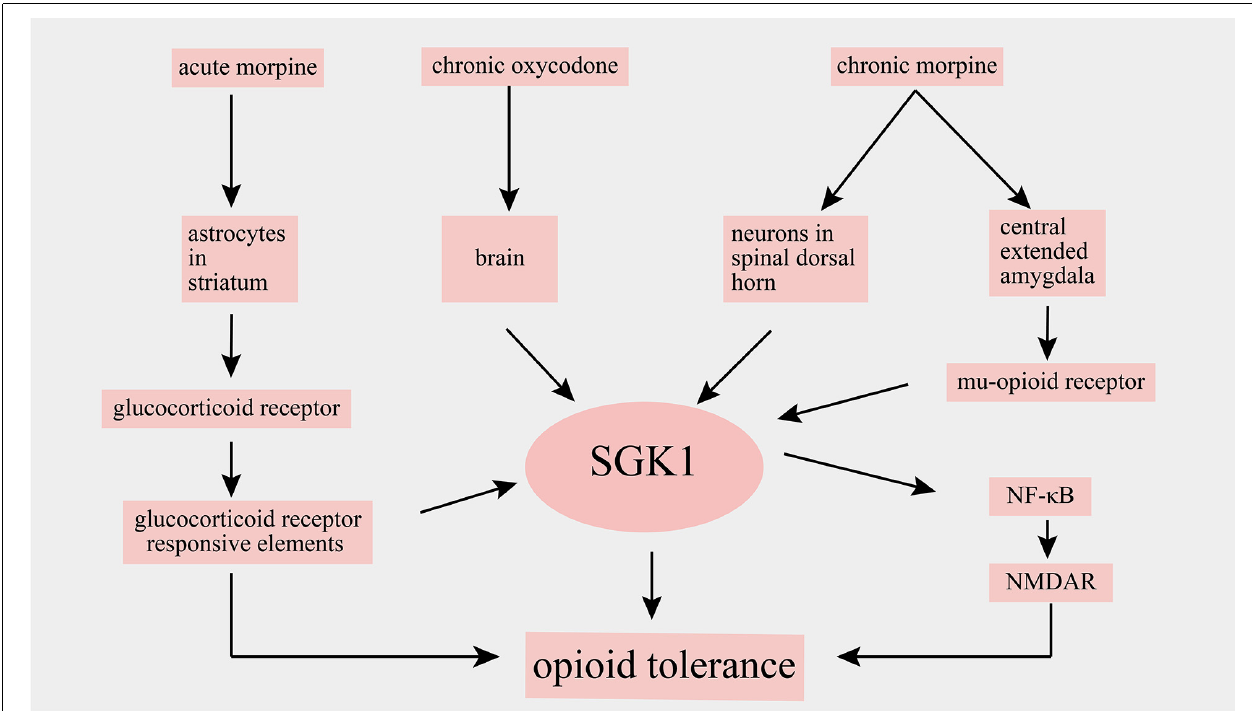
FIGURE 5 | Schematic illustration of involvement of SGK1 in opioid tolerance. SGK1, serum-and glucocorticoid-inducible kinase 1; NF- κ B, nuclear factor kappa B; NMDAR, N-methyl-D-aspartate